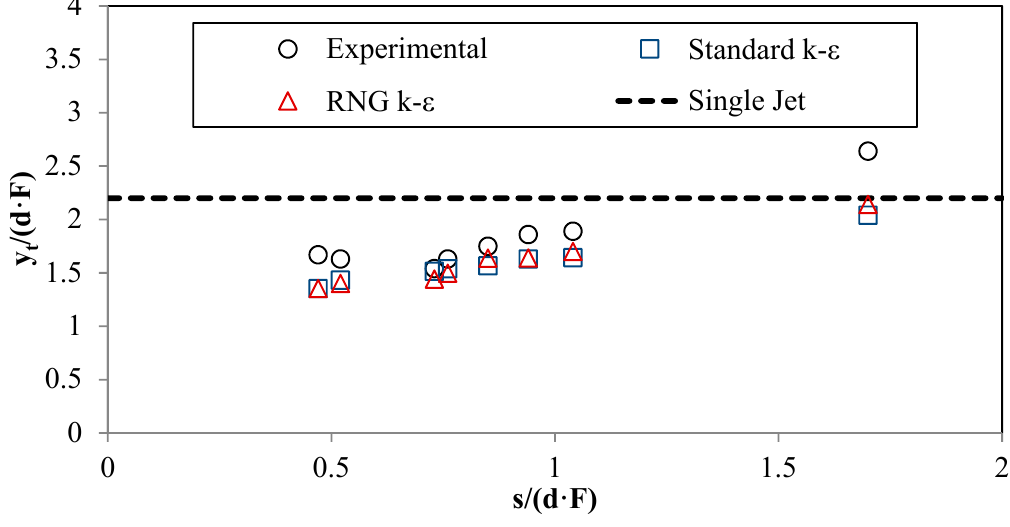
Figure 4. Experimental and numerical results of y t /( d · F ).